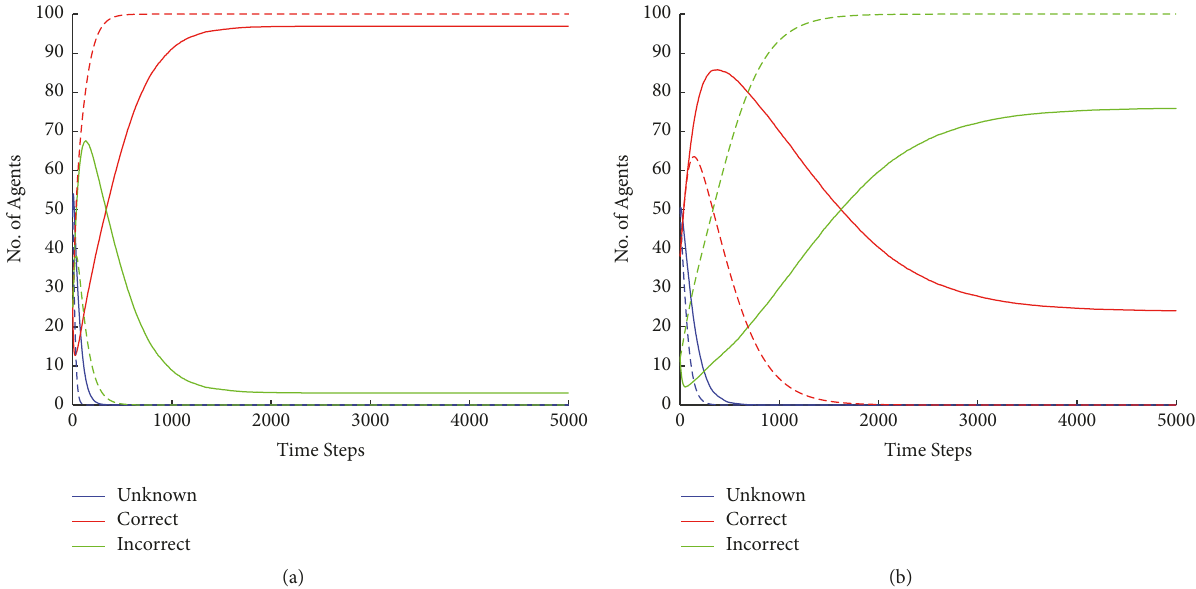
Figure 9: Asymptotes formation in both scenarios. (a) LHL case against nominal scenario; (b) LLH case against wishful-thinking scenario.